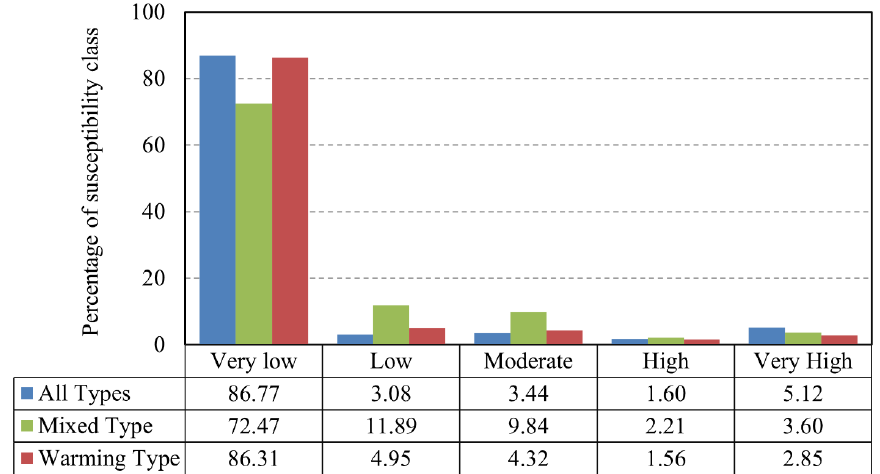
Figure 9. Percentage of different susceptibility levels for different snowmelt flood types.